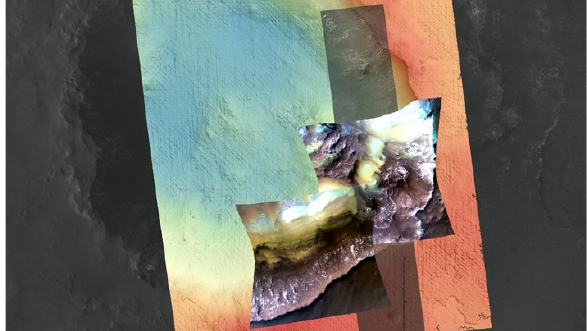
Figure 11. QGIS display of co-registered stack showing part of the HRSC ORI mosaic 12.5m basemap [9] superimposed by